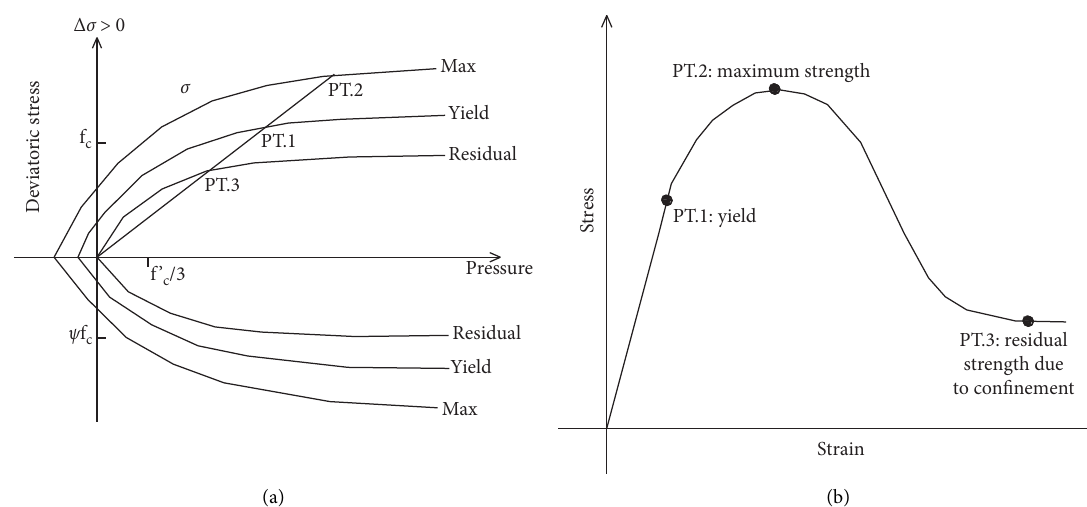
Figure 1: MAT_72R3 material model. (a) Yield surface of concrete model. (b) Constitutive relation of concrete model.